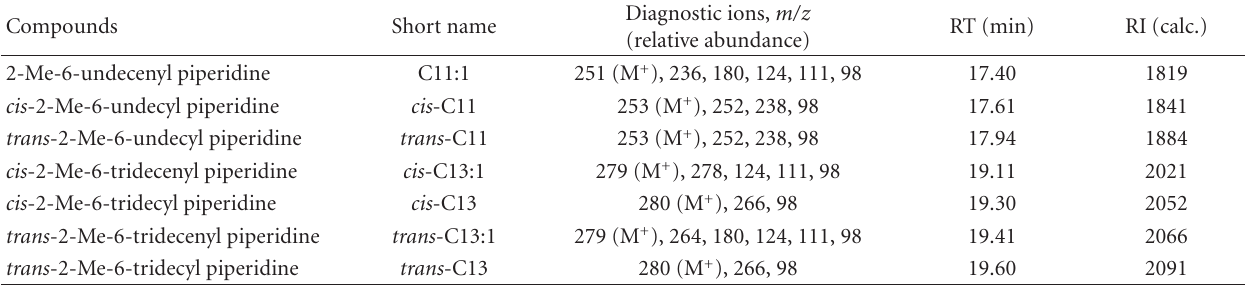
Table 1: Venom alkaloids identified from hexane extracts of Solenopsis saevissima from di ff erent regions within Brazil. Compounds